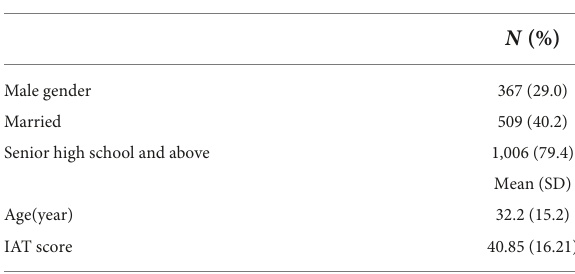
TABLE 1 Sample characteristics ( n =